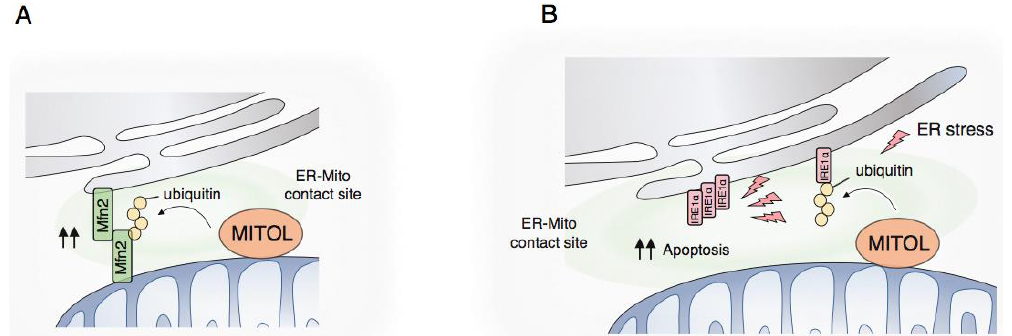
Figure 4. ( A ) Membrane contact site (MCS) formation by MITOL-MFN2 axis. MITOL ubiquitinates mitochondrial MFN2. The ubiquitinated MFN2 enhances its GTPase activity, triggering trans-oligomerization between mitochondrial MFN2 and ER-localized MFN2 for tethering both organelles; mitochondria and the ER; ( B ) UPR regulation by MITOL-IRE1 α axis. MITOL ubiquitinates IRE1 α at ER-mitochondria contact site in unstressed and low-stressed conditions regarding the ER. The ubiquitination of IRE1 α does not perturbate the oligomerization itself in response to ER stress, however, leading to short-term stabilization and smaller oligomerization. In contract, the ubiquitination by MITOL is reduced under severe or chronic ER stress, resulting in continuous oligomerization of IRE1 α and apoptotic switching of IRE1 α signaling.